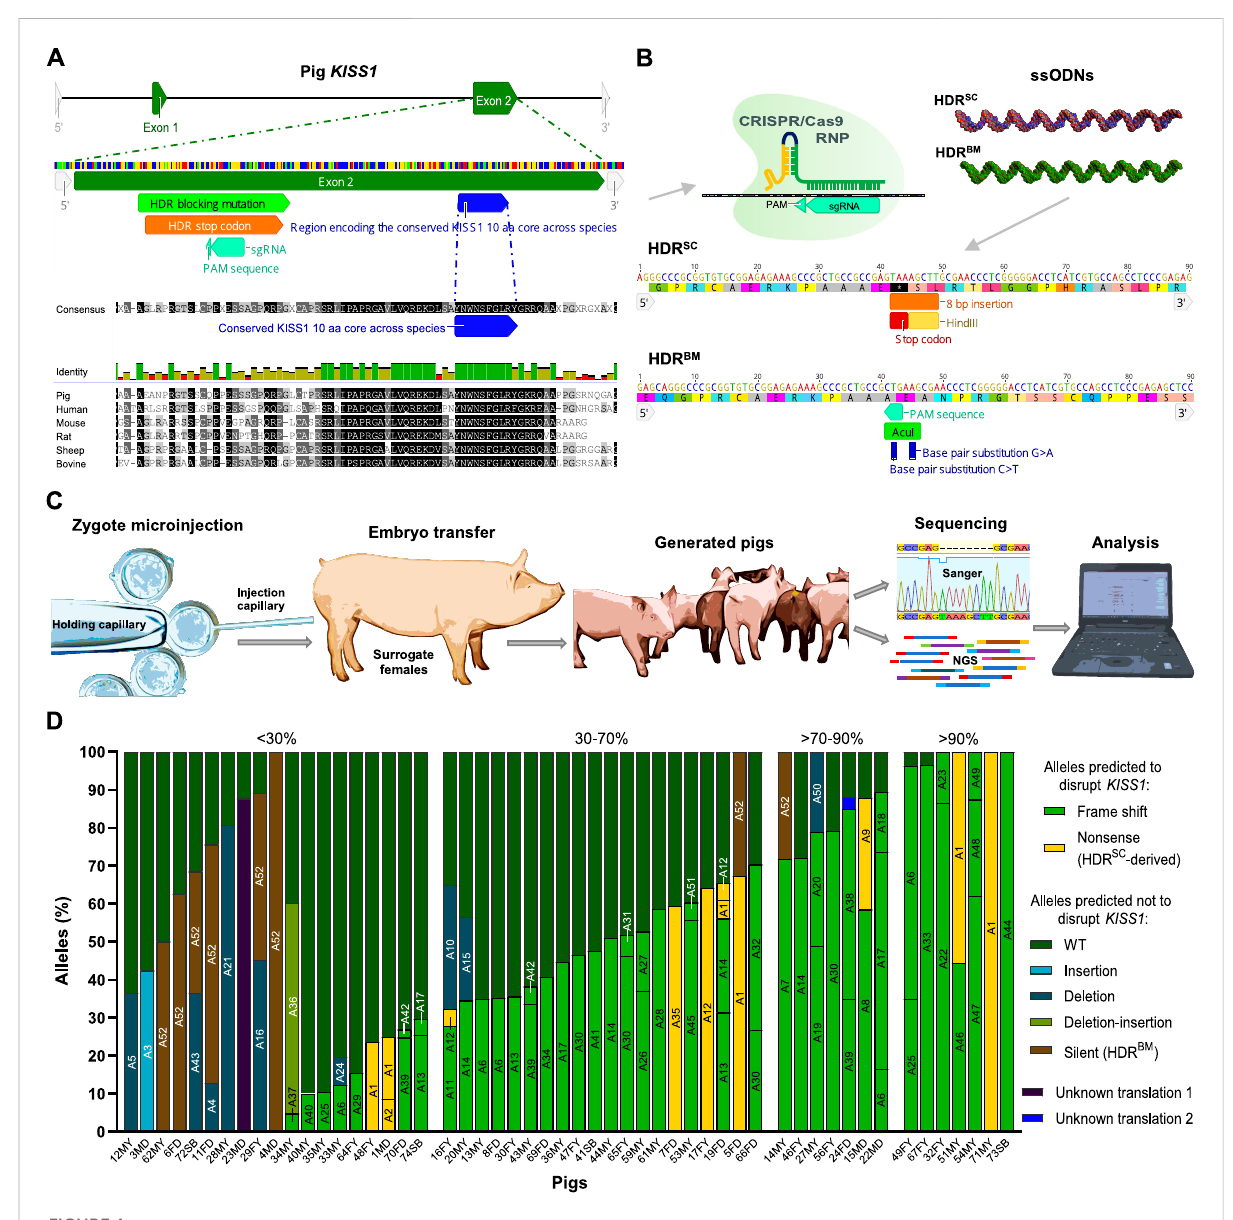
FIGURE 1 Generationandgenotypingof KISS1 -editedpigs via zygoteinjectionofCRISPR/Cas9andsingle-strandeddonoroligonucleotides(ssODNs). (A) Graphics depicting the genomic structure of S. scrofa KISS1 , the gene sites bound by the designed sgRNA as well as the homology-directed repair (HDR) templates, and encoding the conserved amino acid core of this protein. At the lower part, it is shown the kisspeptin sequence alignment among different mammalian species in the region fl anking the highly conserved core of this protein. (B) Schematic representation of CRISPR/ Cas9 RNPs targeting KISS1 besides both ssODNs, and sequences of these HDR templates used to introduce a stop codon and the HindIII restriction site (HDR SC ) as well as synonymous SNPs, to change the PAM sequence, to reduce recutting and generate the AcuI restriction site (HDR BM ). (C) SchematicoftheintracytoplasmicmicroinjectionofCRISPRcomponents and ssODNs into porcine zygotes,transferofinjected embryos,obtention of pigs, and their genotyping for the targeted locus. (D) Bar graph showing gene-edited pigs grouped according to their KISS1 -disruptive editing percentagesand depicting theallelenamesand percentagesineach individual. Inthe X -axis arethepig IDs,inwhichFstands forfemale,Mfor male, Y for Yorkshire, D for Duroc, and SB for